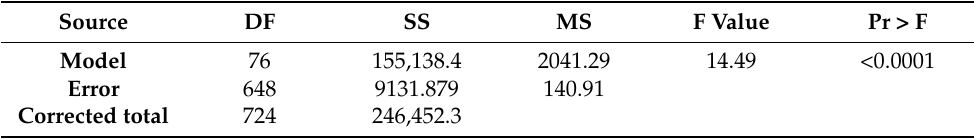
Table 1. Analysis of variance (ANOVA) of plant height for the F 2:3 population .